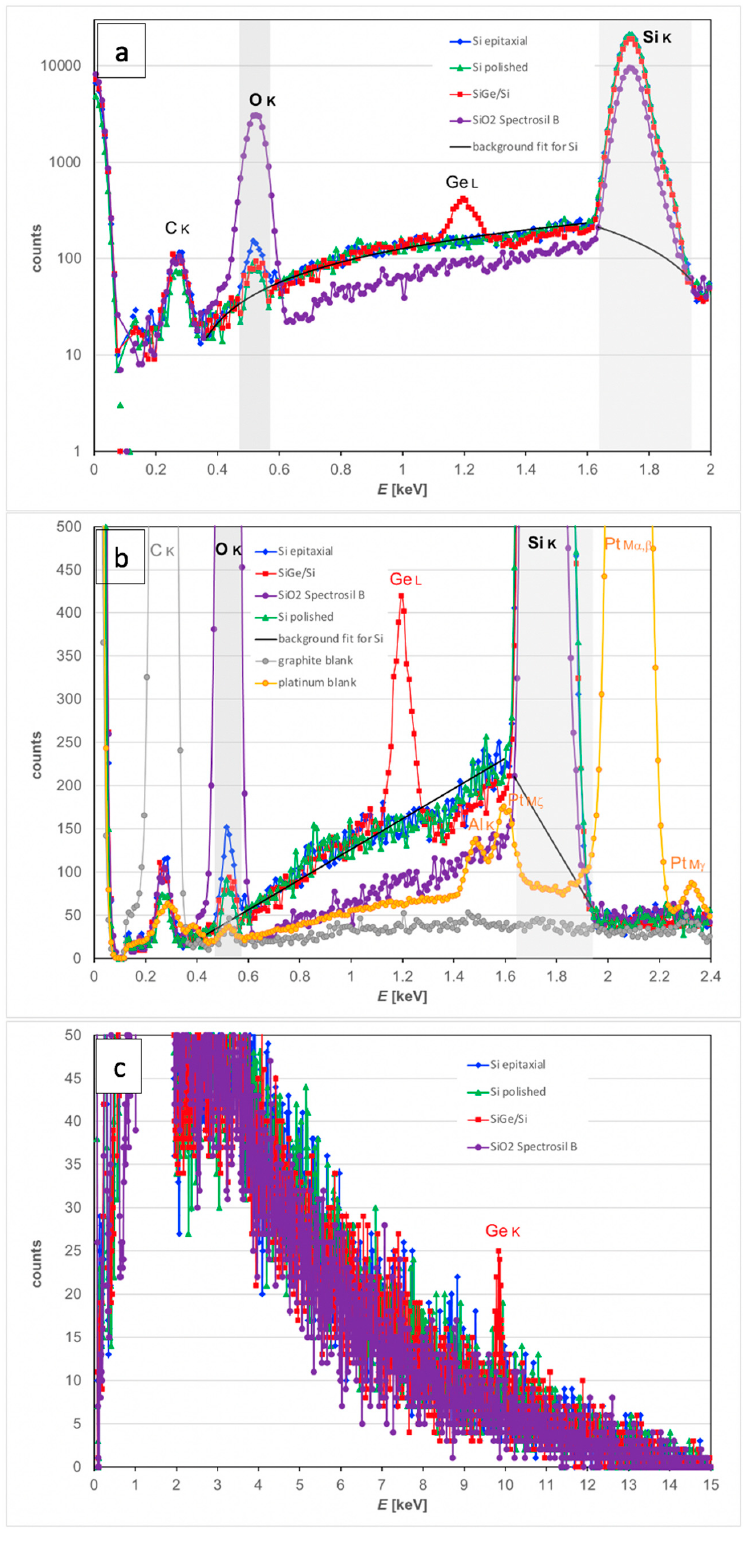
Figure 7. EDX spectra of four specimens at 15 kV: epitaxial Si with 10-year-old native oxide, mechanically polished Si(001) wafer, surface of chemical vapour deposited SiGe 22C86 specimen (cf Figure 8) and fused quartz glass specimen Spectrosil B ©. ( a ) spectral range 0–2 keV on logarithmic scale; ( b ) same spectra as before on linear scale over 0–2.4 keV, with additional data for C and Pt blanks; ( c ) same